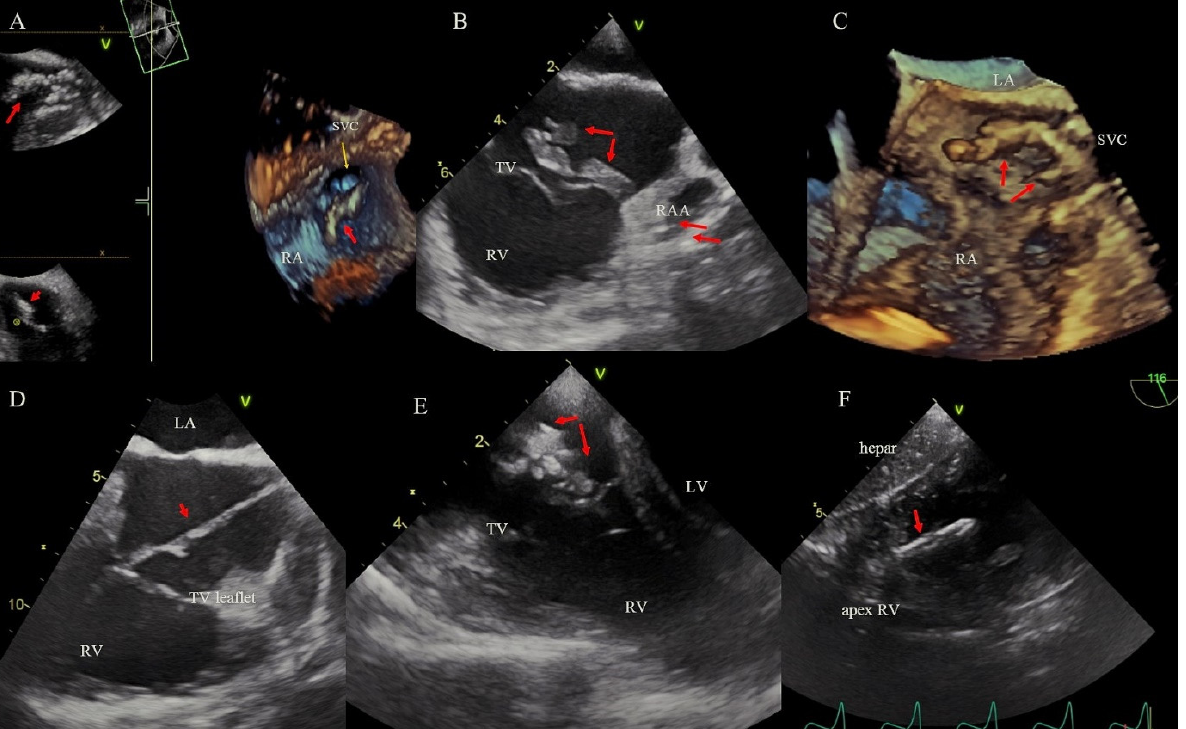
Figure 2. SG (red arrows) in different areas of the cardiovascular system imaged by 2D and 3D TEE. ( A ) SG at the SVC orifice. ( B ) SG leaving the RAA. ( C ) SG in the SVC/RA. ( D ) Long SG stretched between the TV and SVC. ( E ) Large SG in the RA adhering to the septal leaflet. ( F ) SG adhering to the RV endocardium.